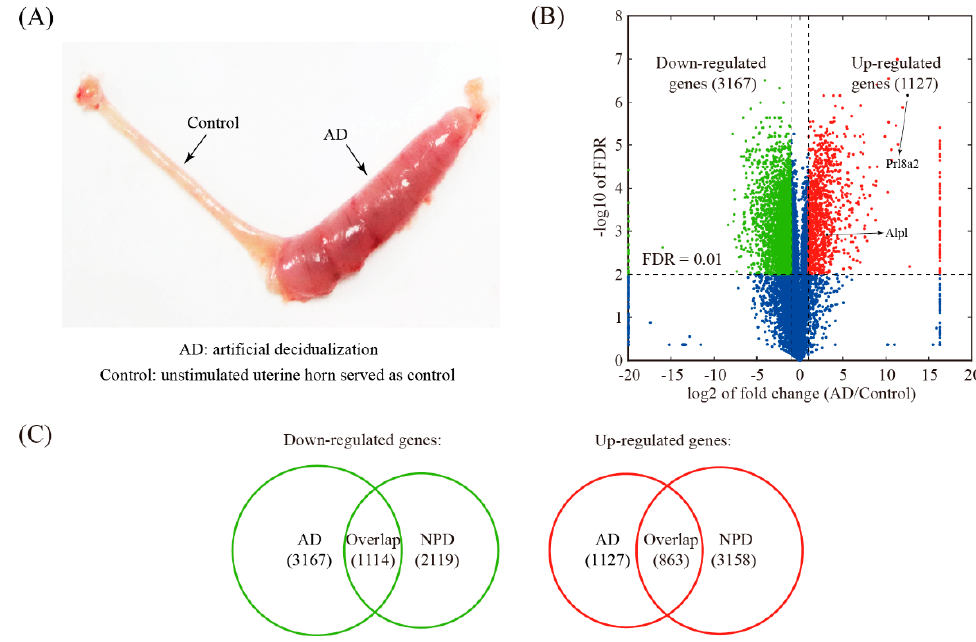
Figure 4. Identification of changed genes in artificial decidualization (AD) model. ( A ) A view of mouse uterus undergoing AD. ( B ) Volcano plot showing the comparison between the oil-stimulated uterine horn (decidualized) and the unstimulated one (served as a control) in mice. The threshold values for differentially expressed genes were: fold change ≥ 2 and FDR ≤ 0.01. ( C ) Venn diagram showing the overlap of down-regulated genes and up-regulated genes and between the AD model and the NPD model of mouse decidualization.